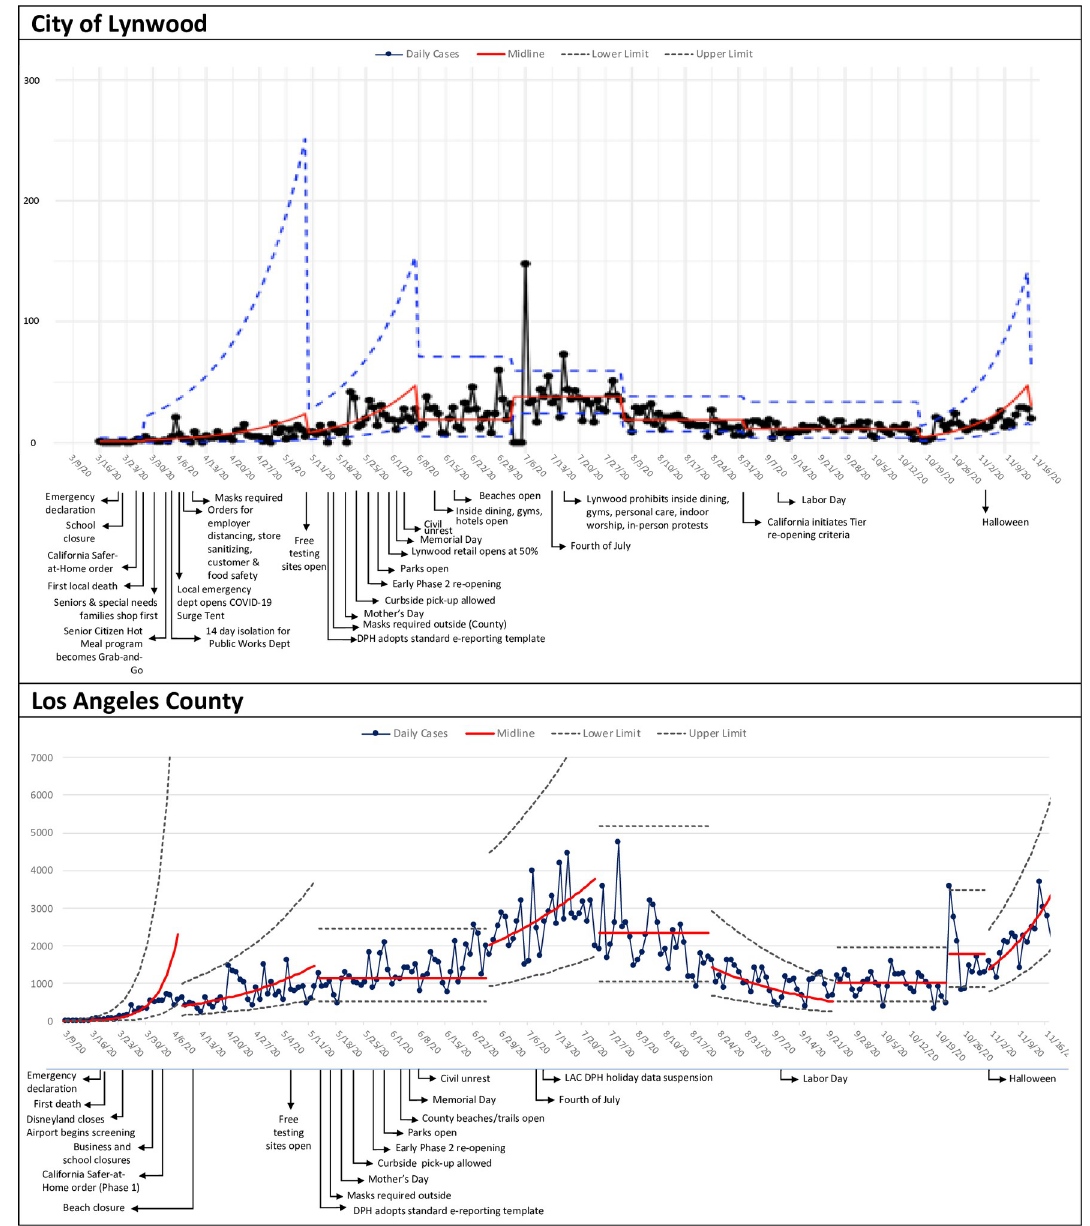
Fig 2. Annotated control charts of COVID-19 cases: City of Lynwood and Los Angeles County.